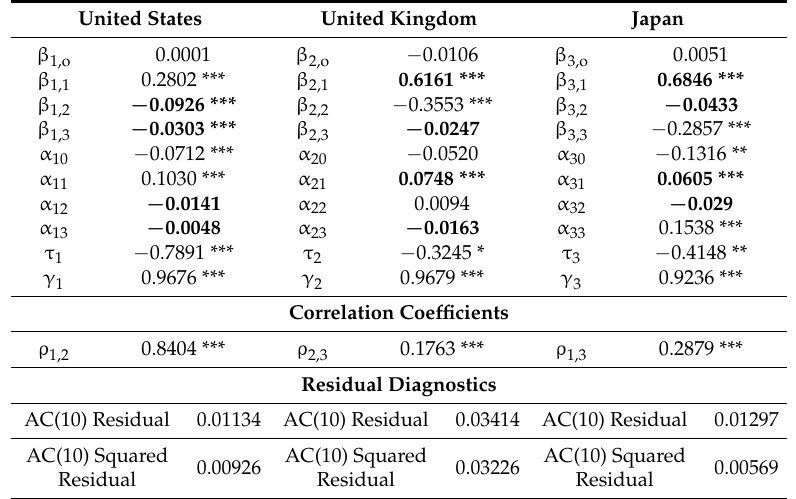
Table A9. Estimation from the multivariate MVR-EGARCH model (conventional equities—post-crisis). United States United